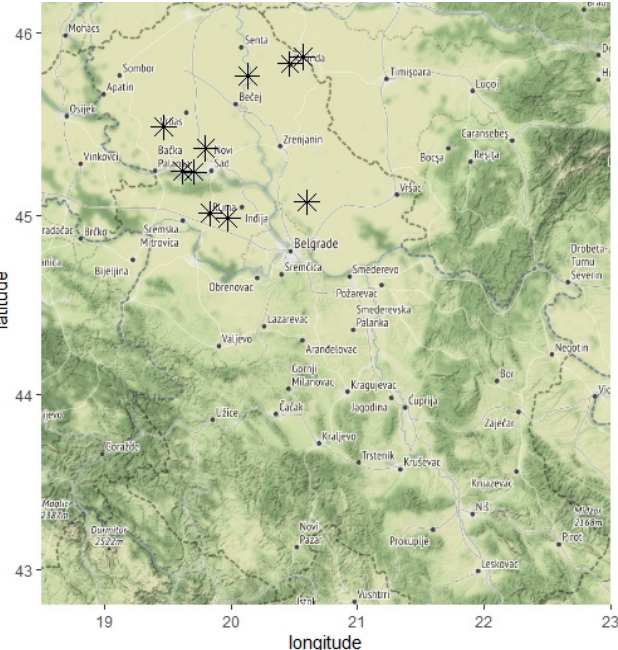
Figure 6. Location map of Vojvodina Province, Serbia. The sampling sites are indicated with asterisks.